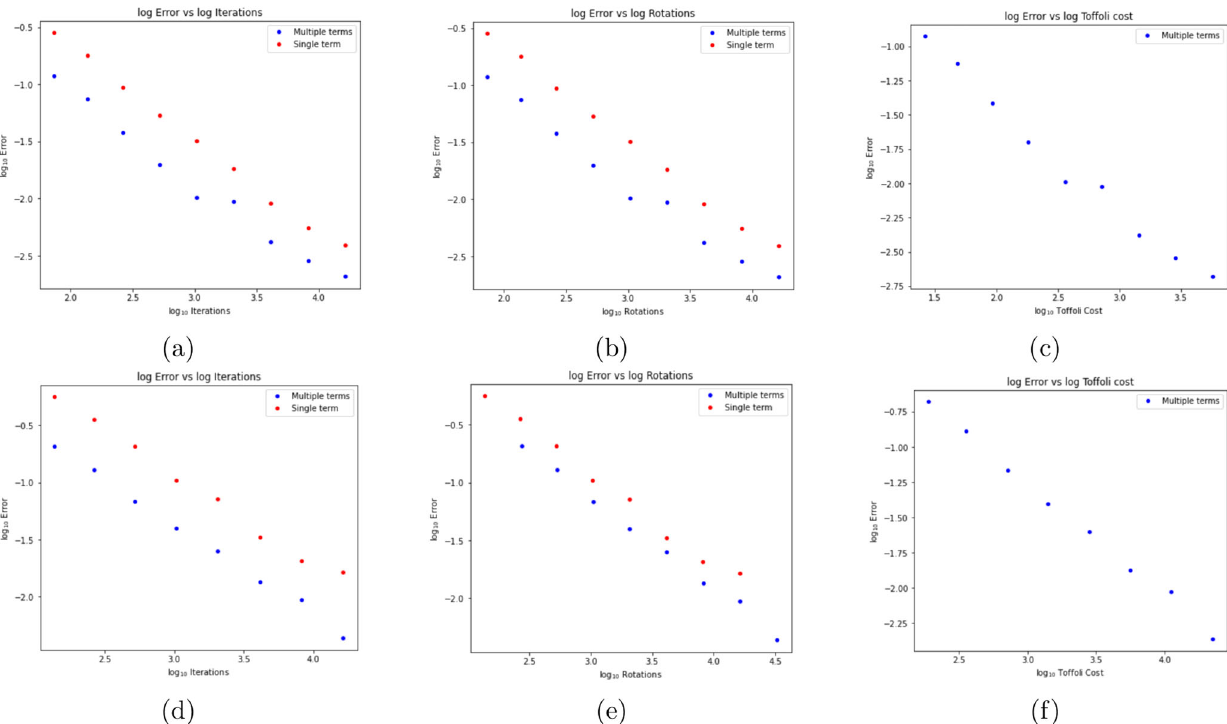
Fig. 7 Simulation of 4 and 6-qubit Heisenberg Hamiltonian. Log-log plots showing number of iterations ( a , d ), R z / cR z ( b , e ), Toffoli-pairs ( c , f ) as function of error, while simulating the 4 ( a – c ) and 6-qubit ( d – f ) quantum Heisenberg Hamiltonian ( H H ) with qDRIFT. The red and blue curve shows the variation when sampling single and multiple commuting Paulis per iteration, respectively. The Y-axis label in all plots is log Iterations , ( b ), ( e ) is log Rotations and ( c ), ( f ) is log Toffoli Cost The X-axis label of ( a ), ( d ) is log 10 10 10